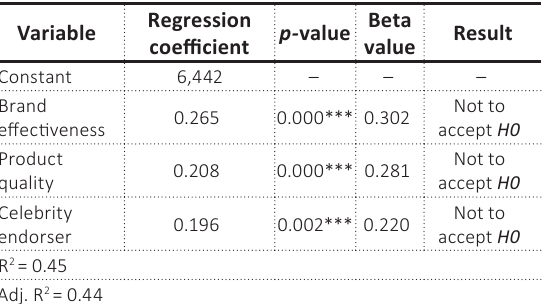
Table 3. Multiple linear regression